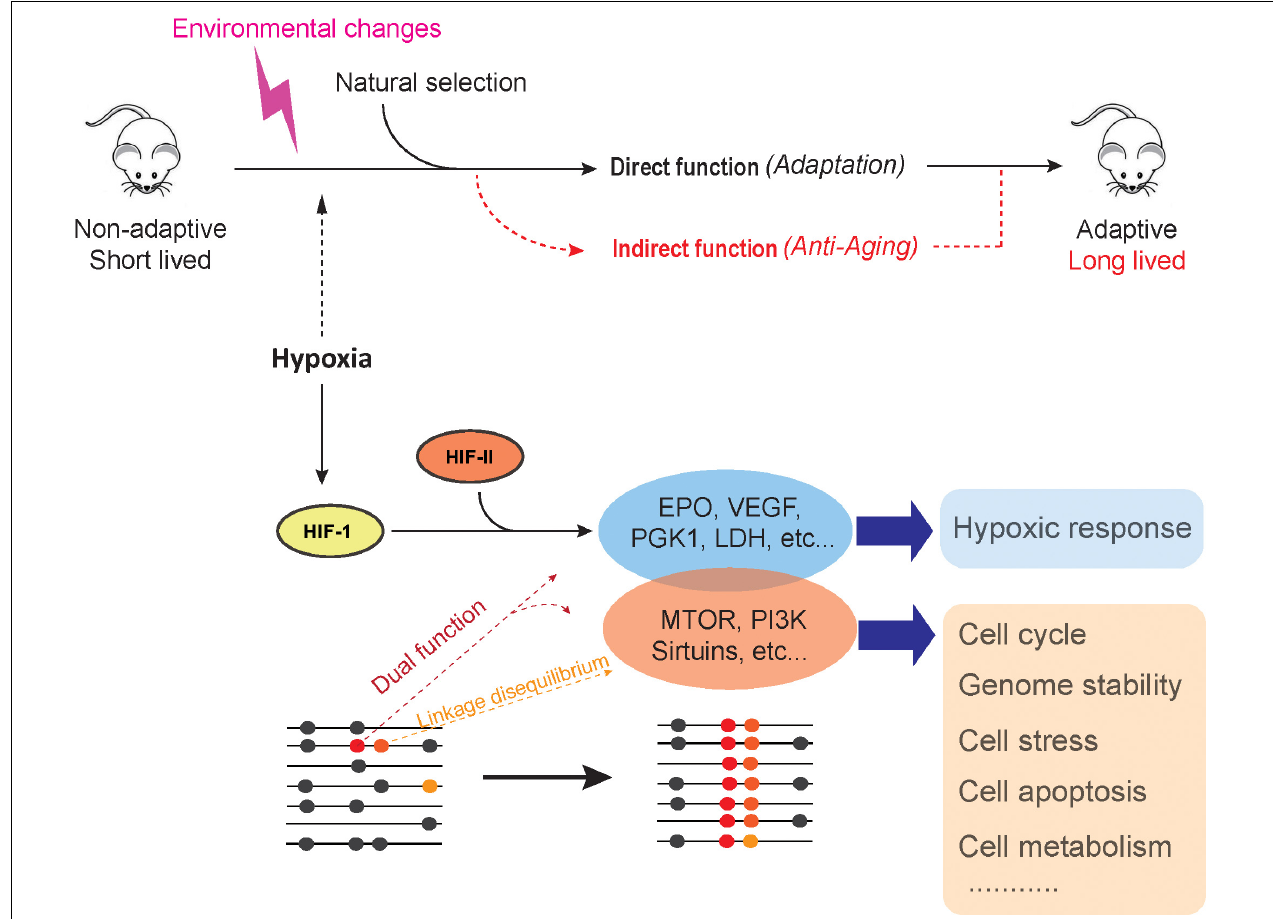
FIGURE 2 | Adaptive-hitchhike model of animal